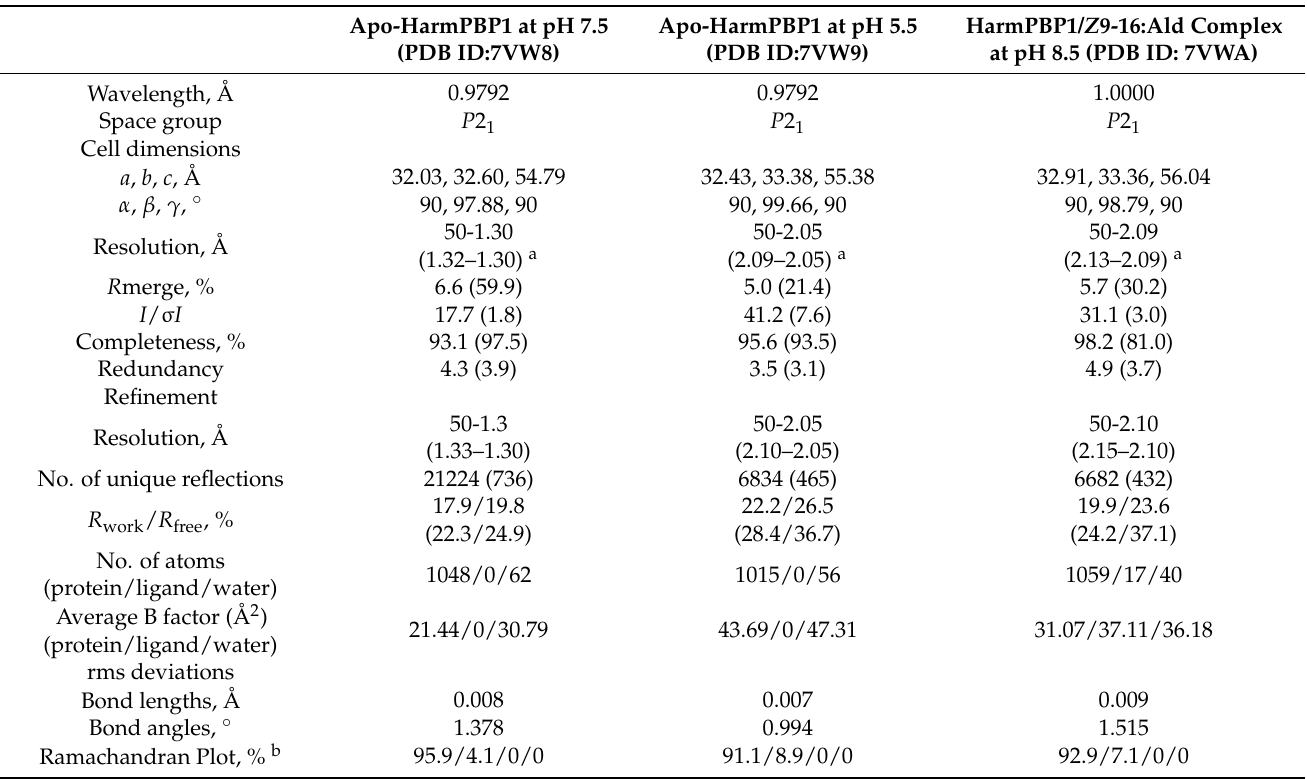
Table 1. Data collection and refinement statistics of HarmPBP1 structures.